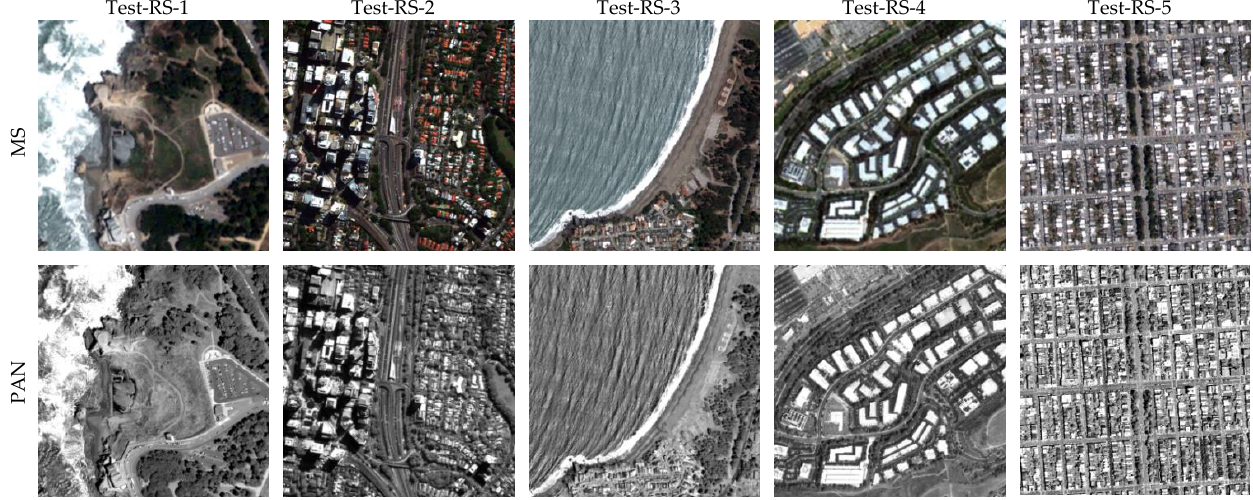
Figure 13. Experimental data